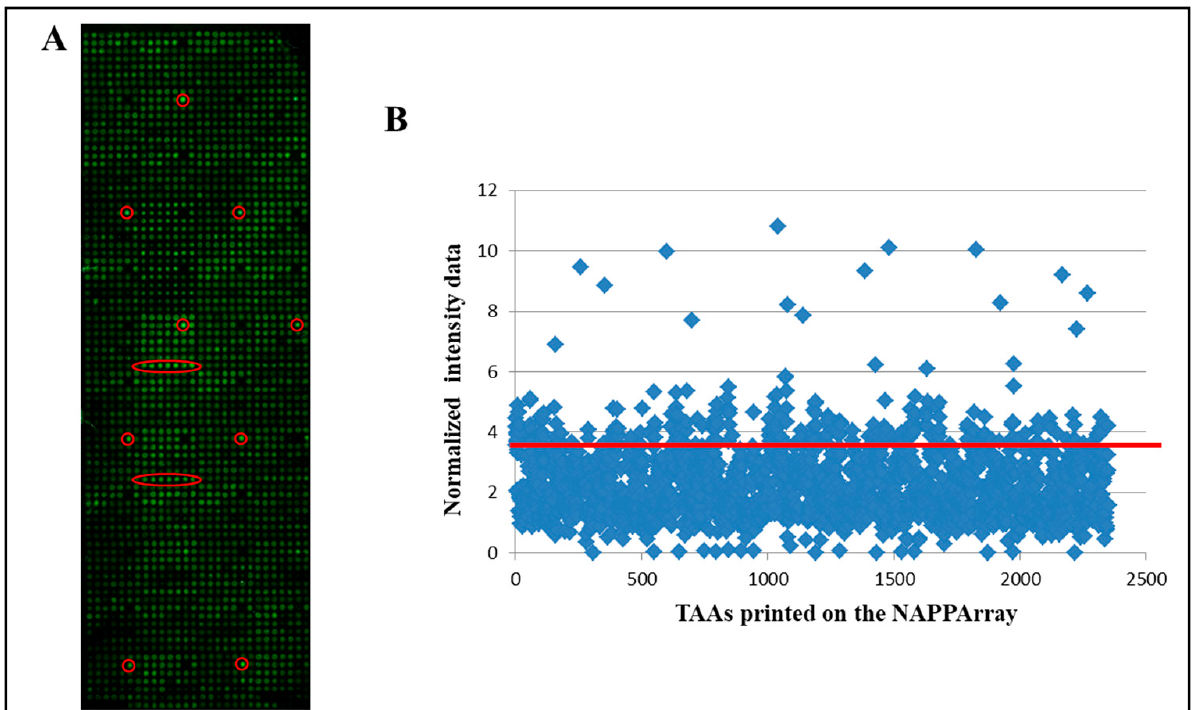
Figure 2. Detection of aAbs on NAPPAarray. ( A ) Illustrates a representative slide image showing the antibody reactivity against TAAs included on the NAPPArray. aAbs against tumor antigens are highlighted in red. ( B ) Corresponds to scatter plot of the total intensity of aAbs against all the TAA contained in the NAPPArray. Red line corresponds to mean of the normalized values of empty pANT7_cGST vector spots + 3SD and the positive aAbs defined taking into account the normalization values (>mean of the normalized values of empty pANT7_cGST vector spots + 3SD).